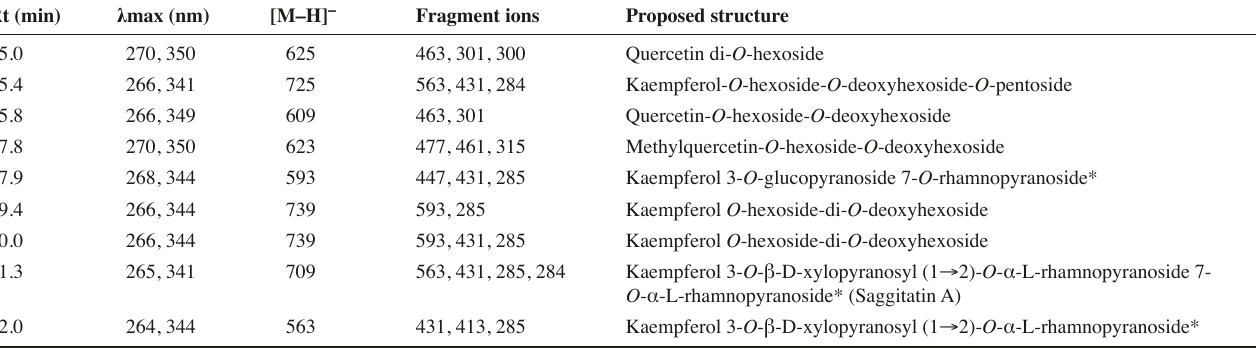
* Substances identified based on comparison of their retention time and spectra with those of the respective isolated compounds.